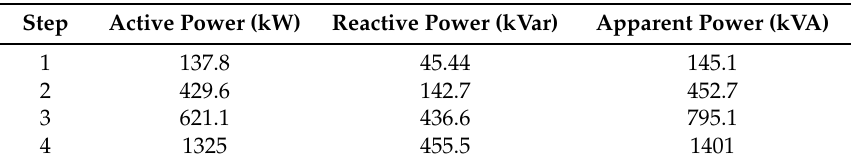
Table 4. Output Power of WSU Generators.